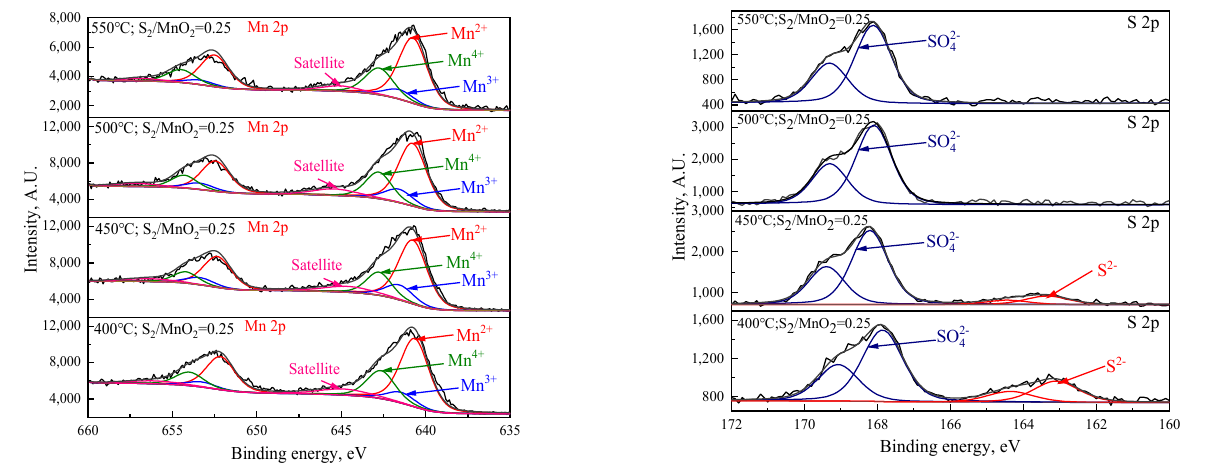
Figure 7. XPS analysis of roasted products as functions of roasting temperature and S 2 /MnO 2 molar ratio (roasting time: 30 min).